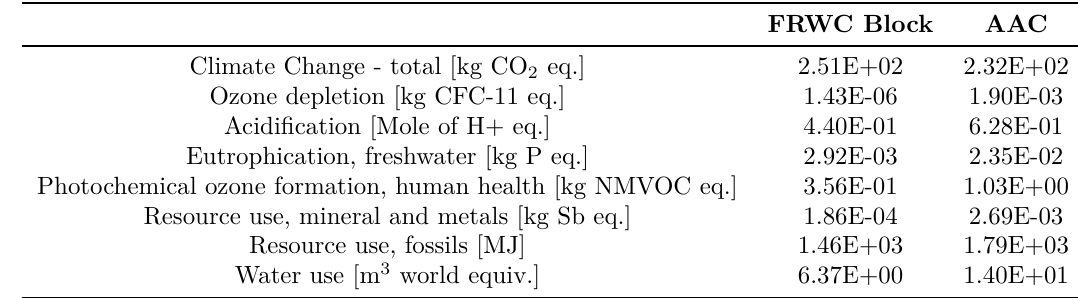
Table 5. Comparison of the environmental performance of lightweight block with AAC block (results of A1-A3